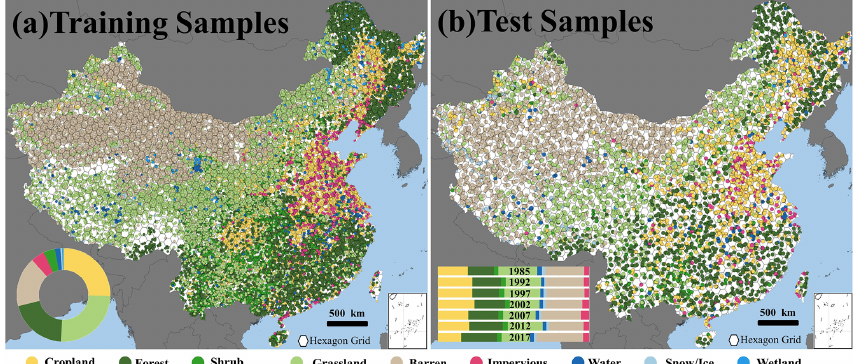
Figure 2. Spatial distribution of visually interpreted training and test samples. The proportions of each land cover class were shown in the inner